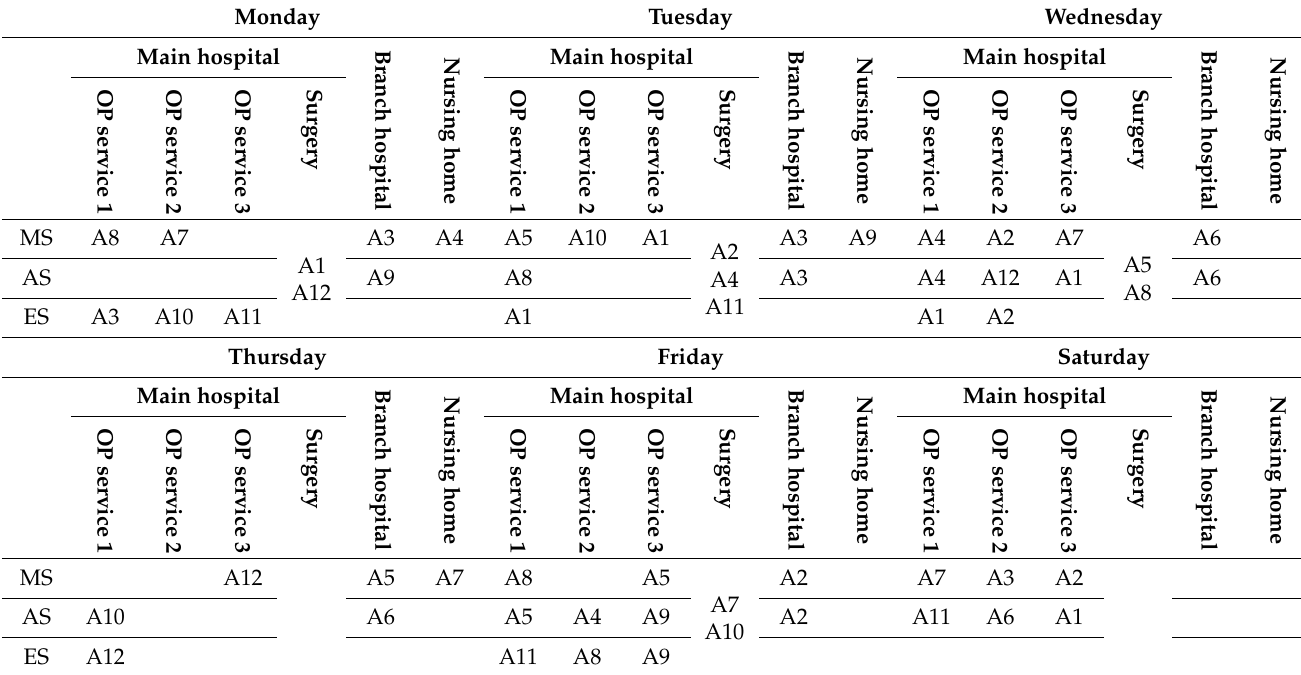
Table 5. Physicians’ duty schedule.